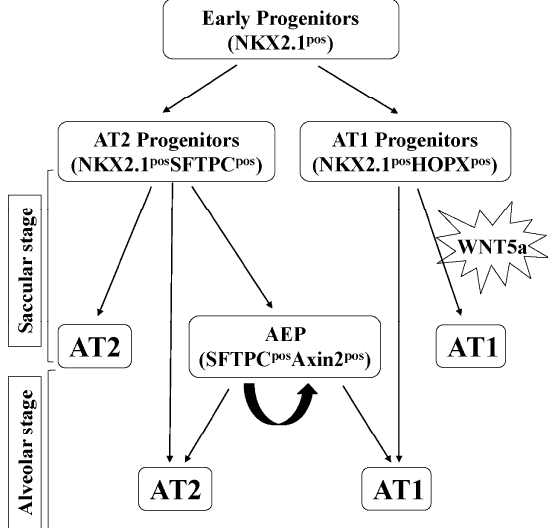
Figure 9. A simplified model indicating the role of WNT5a in AT1 and AT2 cell differentiation. During the saccular stage, WNT5a activity is required for differentiation of AT1 cells from NKX2.1 pos HOPX pos AT1 progenitors. During alveologenesis, WNT5a activity does not appear to be required for AT1 and AT2 cell differentiation. AEP: alveolar epithelial progenitors.